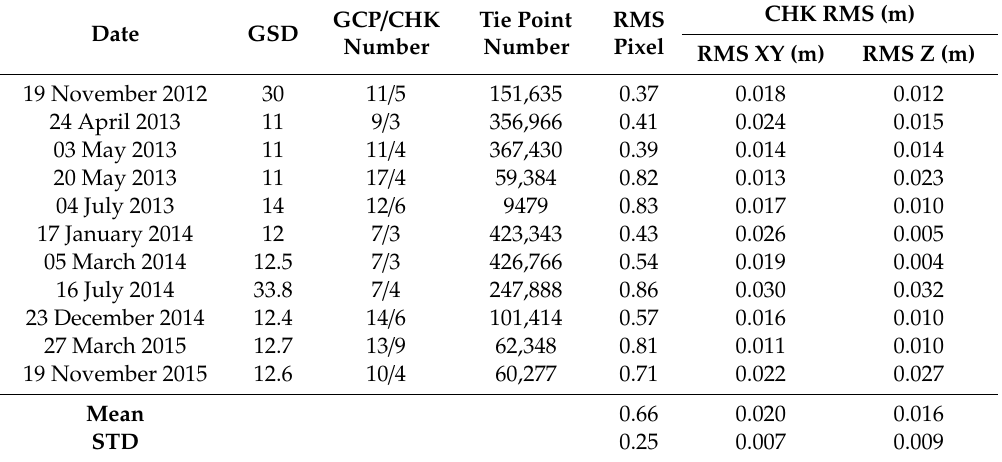
Figure 5. Examples of targets for GCP and CHK points as seen from 40 m flying height. ( a ) White circles on black background (inside the white circle there is small black circle for accurate image measurement) printed on PVC foam board. ( b ) Circle / sector target sprayed on the ground with reflective red paint and a cardboard template. ( c ) Natural and well defined natural points (road reflective markers and corners on road surface markings). Table 2. Orientation errors.